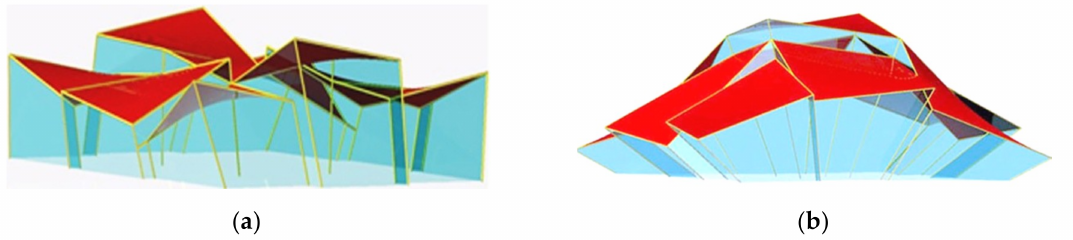
Figure 11. Various types of free-form structures. ( a ) Configuration 1; ( b ) Configuration